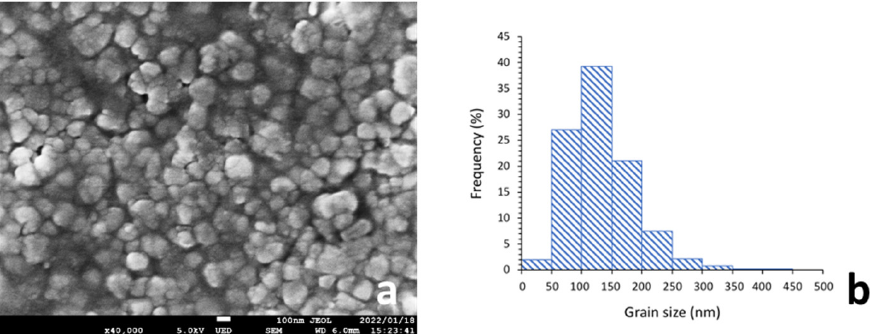
Figure 1. Particle size (40,000× microscopic images) and distribution of zirconia filler at 10 wt.%: ( a ) Particle size determined by the linear intercept method (average 206 µm) and ( b ) Minimum 600 grains measured, with the highest size distribution between 100 nm and 150 nm.